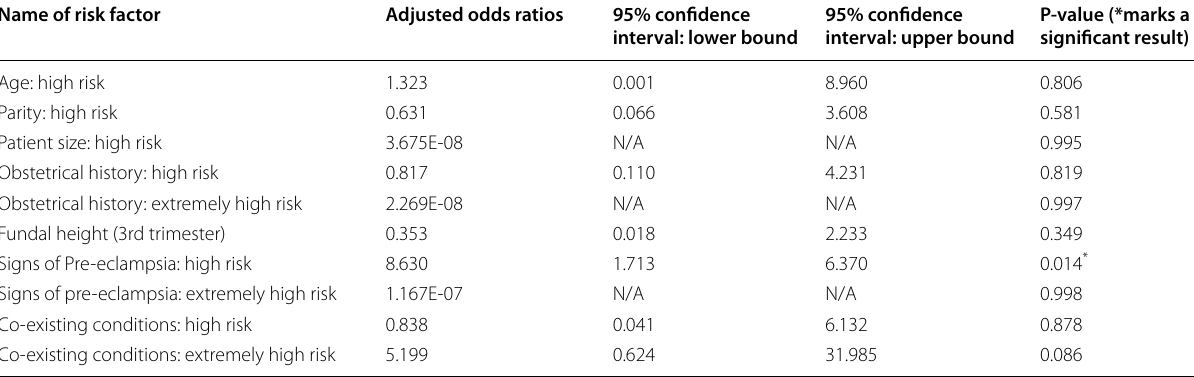
Table 4 Multivariate logistic regression analysis for the risk factors included in the CMDS with mortality in-hospital as the